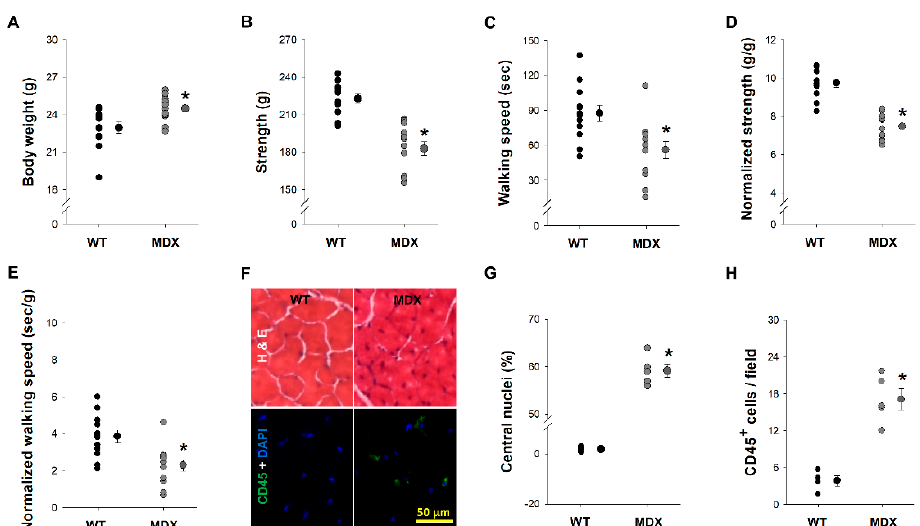
Figure 2. Characteristics of WT and MDX mice at seven weeks of age. Body weight ( A ), strength determined by the grip meter test ( B ), walking speed determined by the Rota-rod ( C ), normalized strength ( D ) and normalized walking speed ( E ) were evaluated in WT (black filled circles) and MDX (grey filled circles) mice. Data are presented as individual points (each mouse) with the mean and standard error of the means (S.E.M.). Representative images of hematoxylin & eosin, DAPI and CD45 + cells at 20 × magnification are shown in ( F ). The mean percentage of central nuclei ( G ) and CD45 + cells per field ( H ) in EDL muscles of WT (black filled circle) and MDX (grey filled circle) mice were quantified. * indicates p < 0.05 comparing WT to MDX mice. Sample size: for body weight and physical performance, n = 12, for histology, n = 4–6 in each experimental group. Table 2. ONX-0914 treatment for a period of 9 days in WT